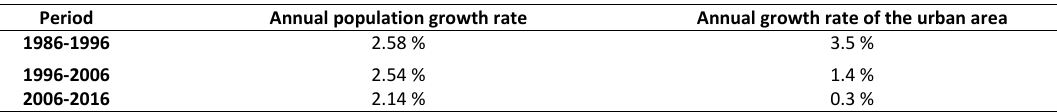
Table 9: The comparison between annual growth rate of population and urban area